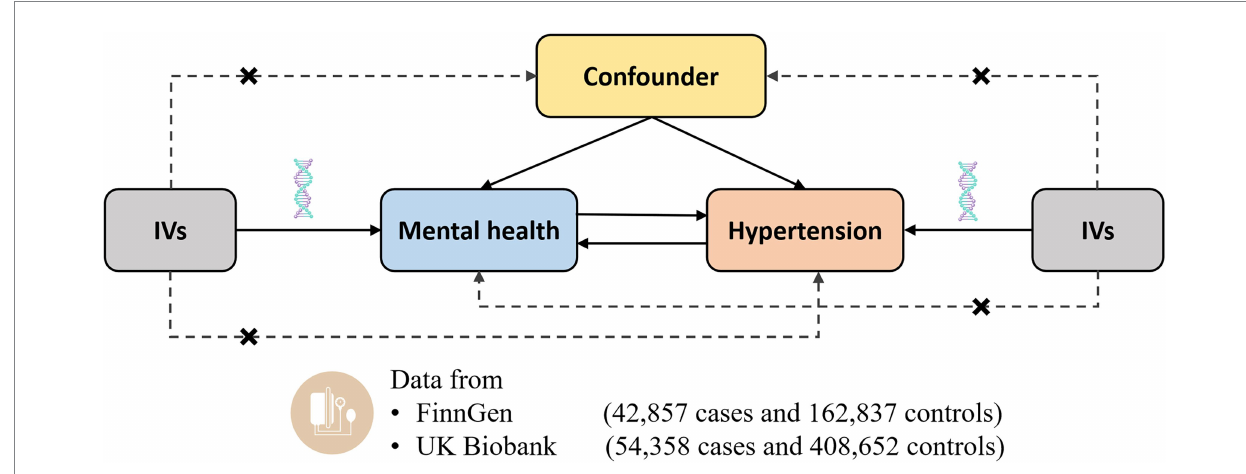
FIGURE 1 Design of the current two-sample Mendelian randomization study. Three core assumptions were as follows: ( α ) Relevance assumption; ( β ) Independence assumption; ( γ ) Exclusion restriction. IVs, instrumental